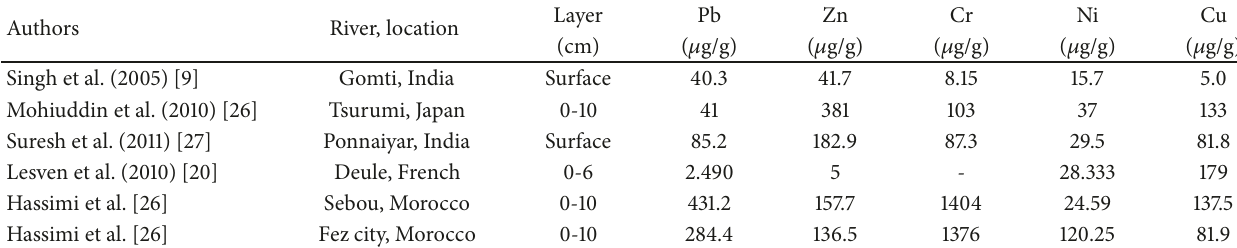
Table 1: Maximal metal trace contents in Moroccan and international